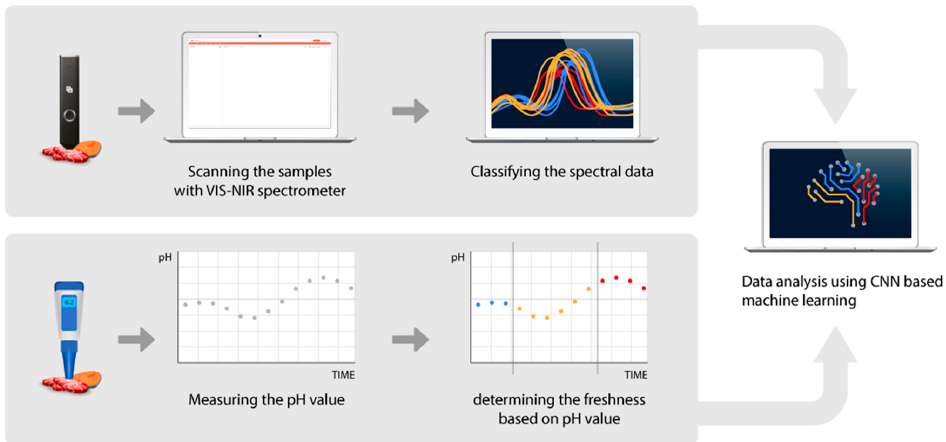
Figure 1. Overview of the food freshness estimation process using a portable visible/near-infrared (VIS-NIR) spectrometer, LinkSquare. As the rotting process of the sample continues, the spectral responses are collected over time with a LinkSquare device (above), and the pH values are measured at the same time (below) to determine the freshness of the samples. The spectral response data is used to train a machine learning model for the food freshness estimation (right).